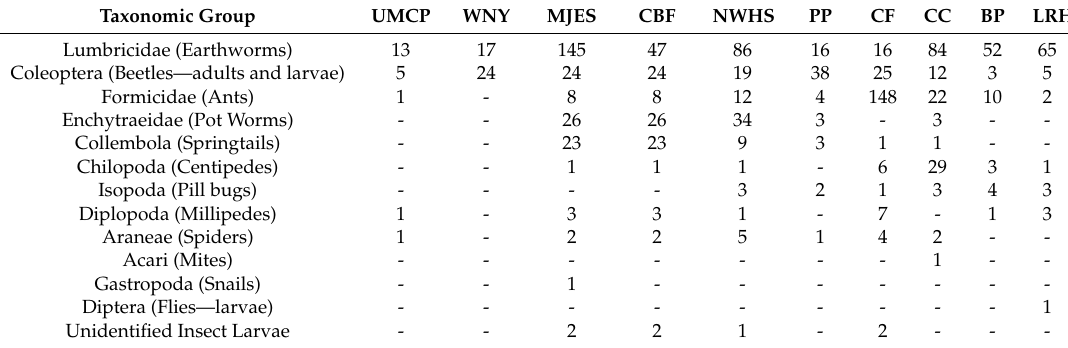
Table 3. Abundance of macroinvertebrates found at field sites. Values represent total number of individuals counted at